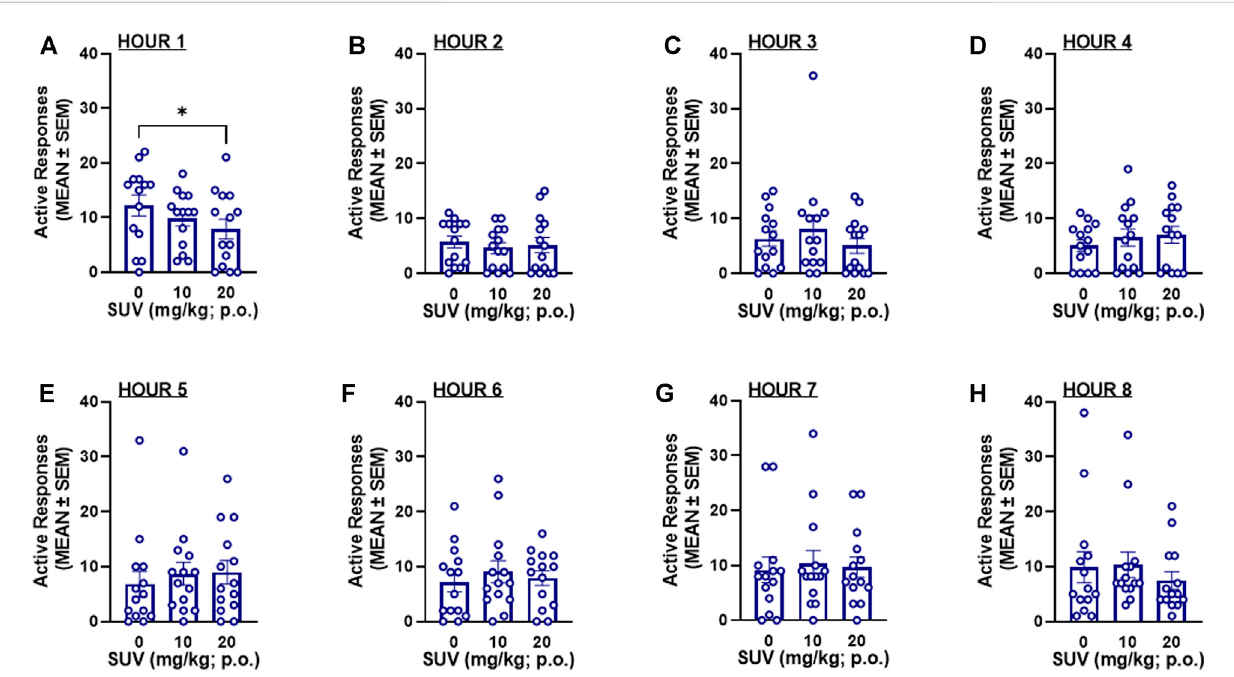
FIGURE 4 Oxycodone self-administration following suvorexant administration in males ( n = 15) during the fi rst hour of the session (A) and during each subsequent hour (B) : hour 2, (C) hour 3, (D) hour 4, (E) hour 5, (F) hour 6, (G) hour 7, (H) hour 8 of the 8-h session. * p < 0.05, vs. 0 mg/kg (Bonferroni multiple-comparison post hoc test).